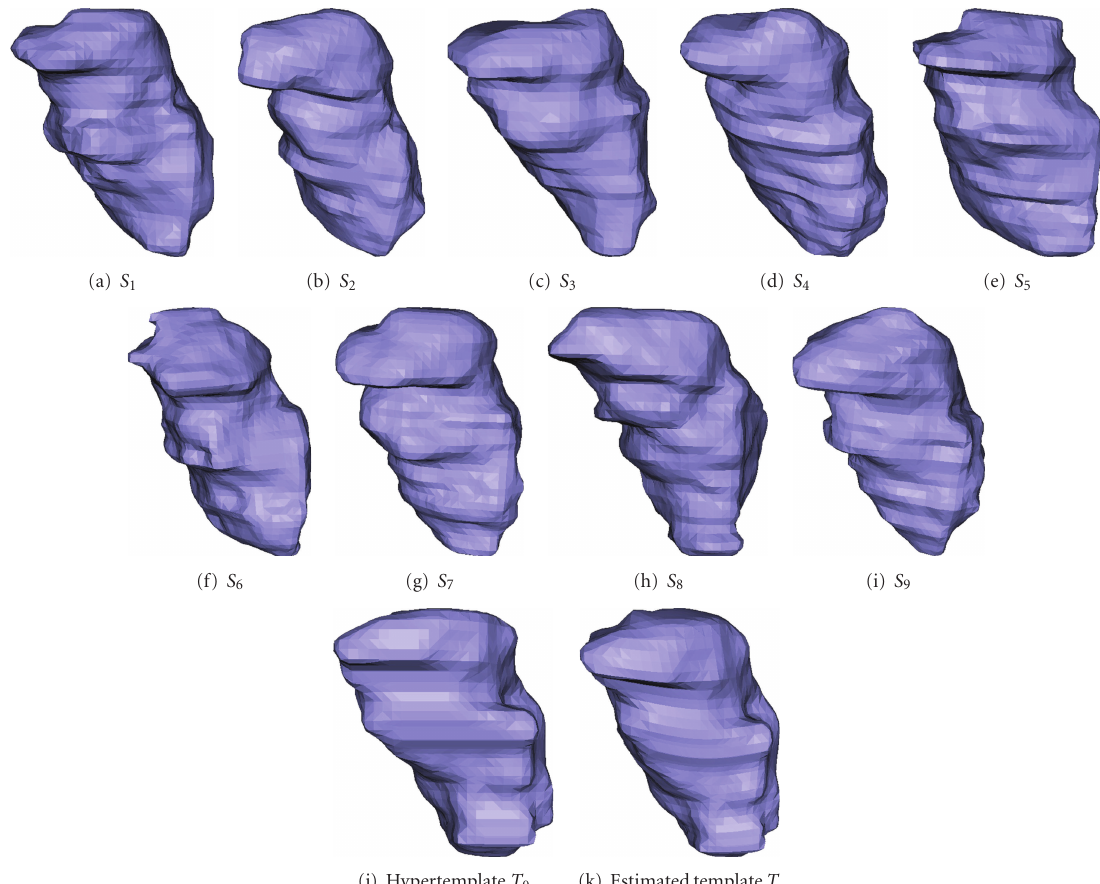
Figure 3: Estimating the surface template from 9 thalamus data. (a) − (i) observed surfaces. (j) is the hypertemplate. (k) is the result. (iii) Solve (7) initialized with the hypertemplate T 0